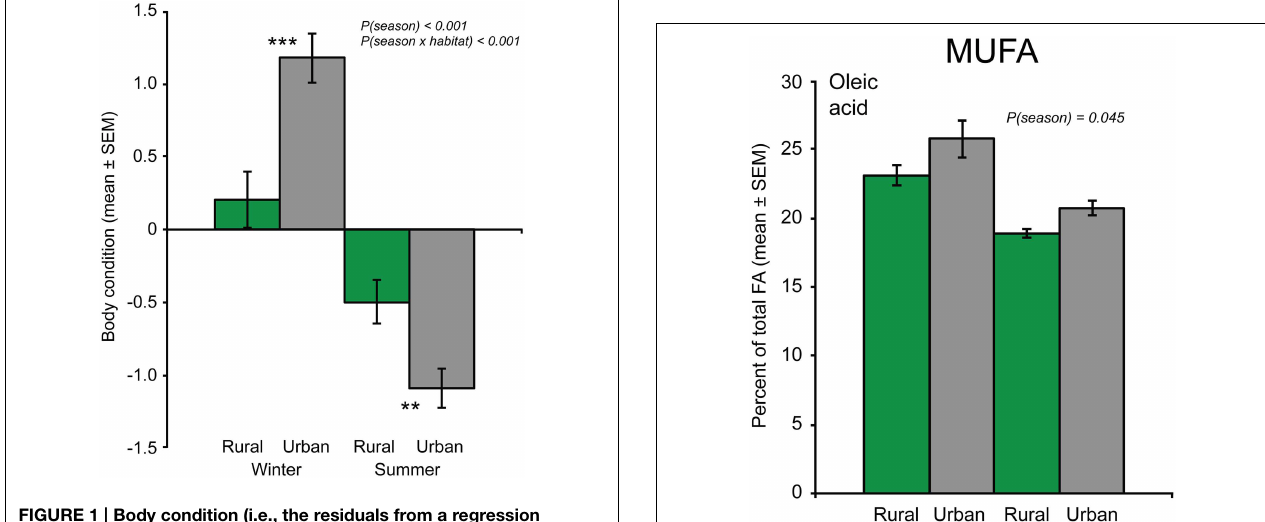
Frontiers in Ecology and Evolution |